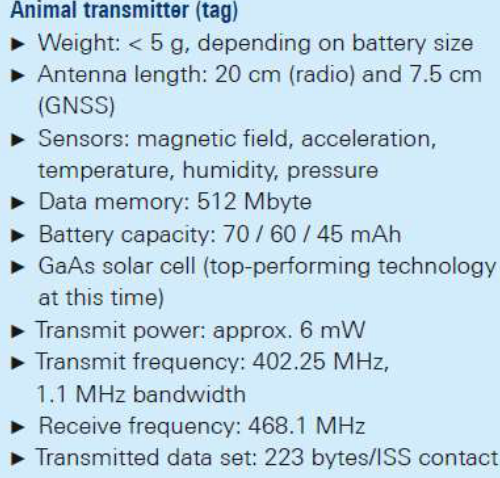
Figure 17. ICARUS tag overview.